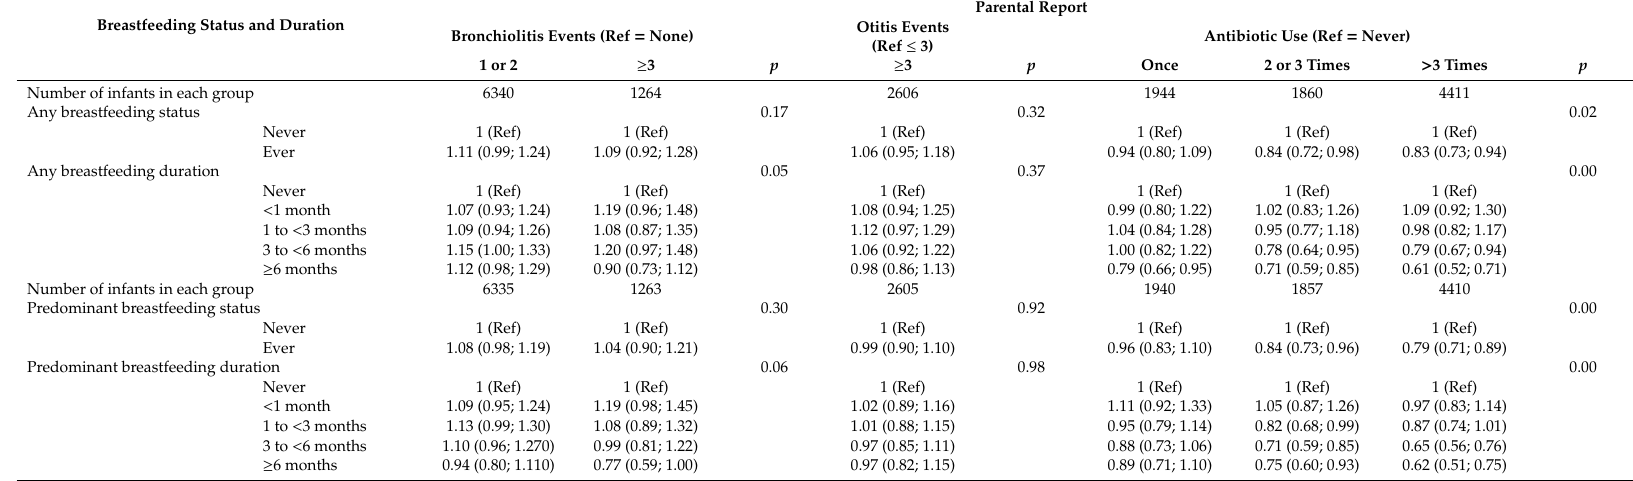
Table 3. Association between breastfeeding and parent reports of bronchiolitis events, otitis events, and antibiotic use: multivariate analyses ( n = 10,349). Breastfeeding Status and